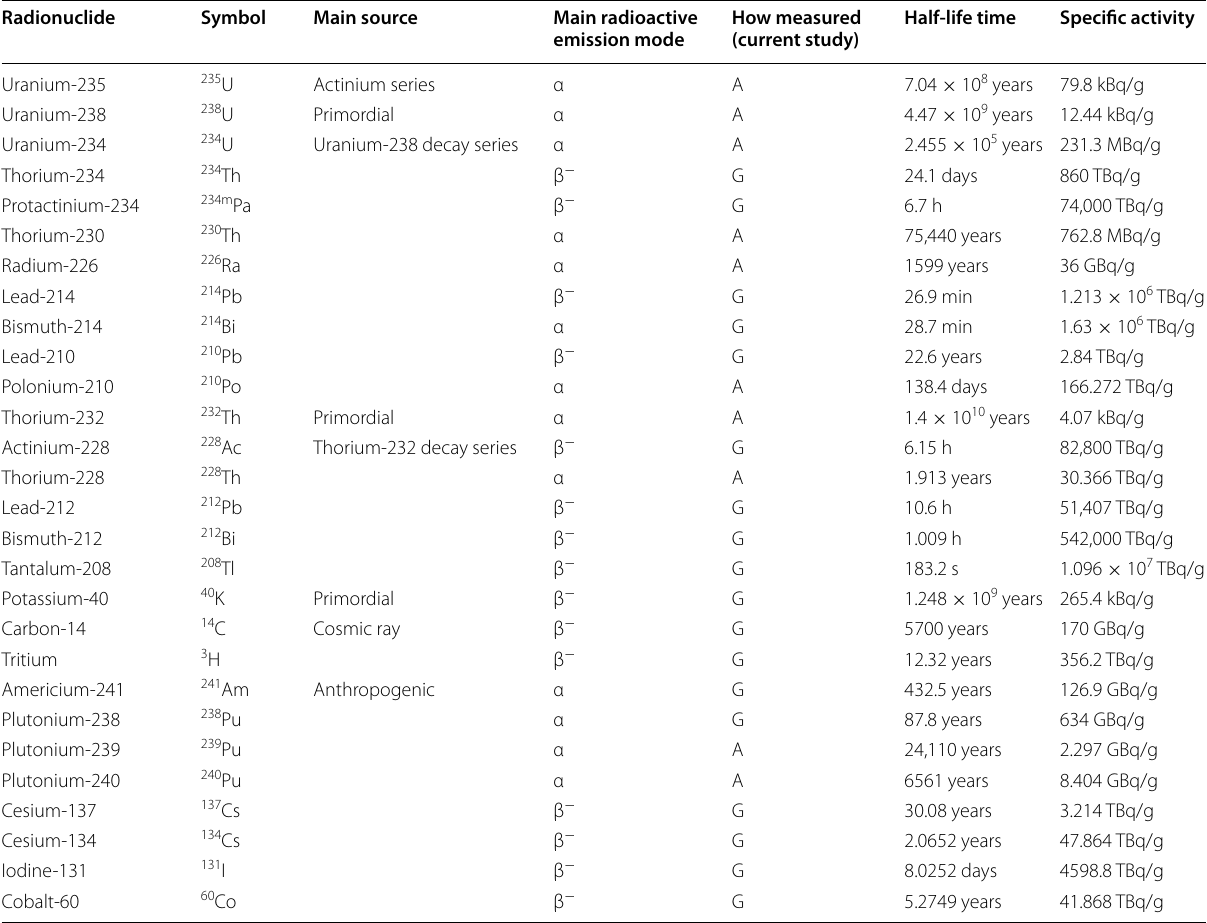
tional file 1: Table